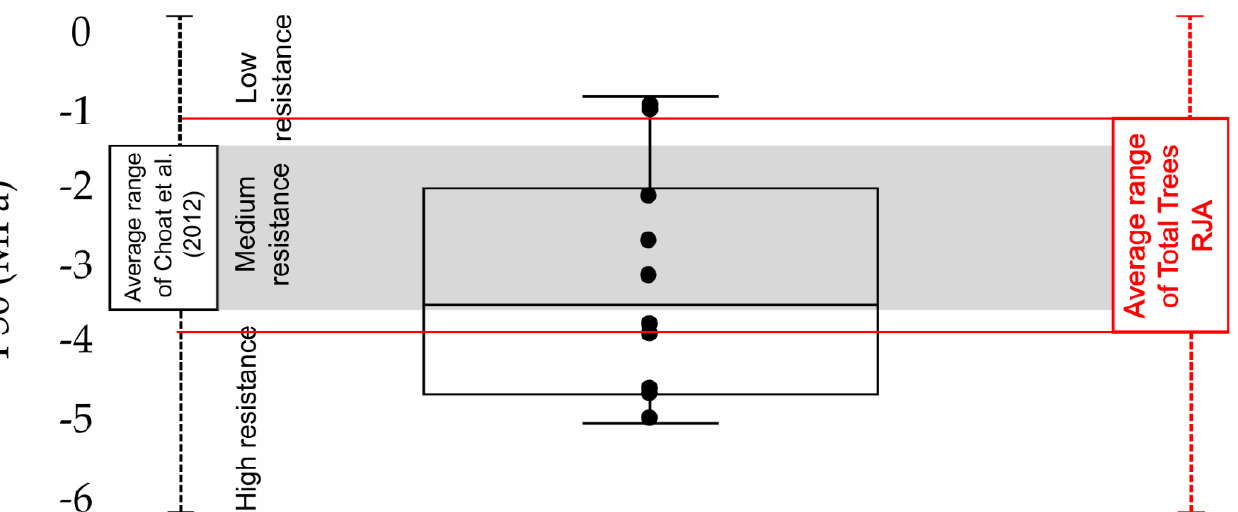
Figure 5. πTLP of the species sampled by diamete r (DBH). Threshold based on [38].